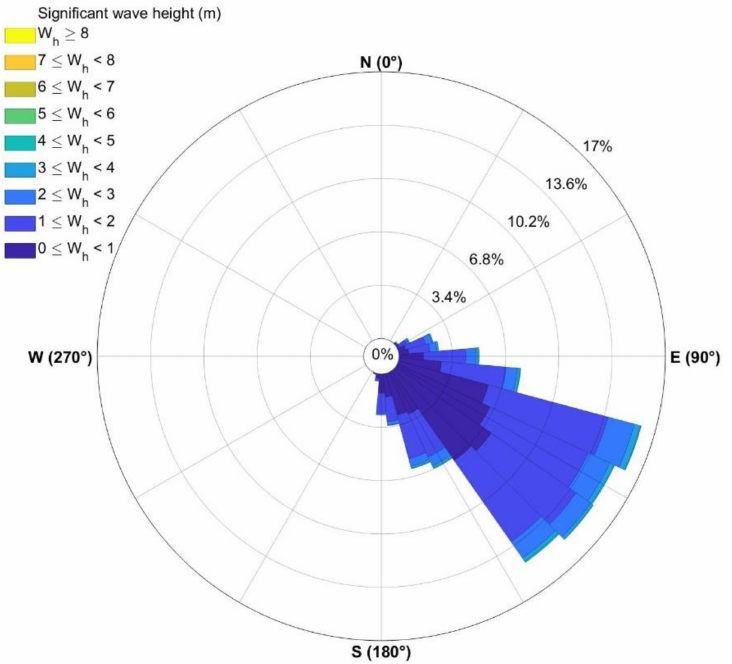
Figure 4. Significant wave height and its direction in the period from January 2001 to December 2018 observed at Hitachinaka port, nearby the Hitachi Beach